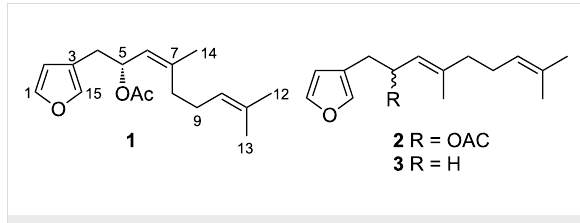
Figure 1: ( − )-(5 R ,6 Z )-Dendrolasin-5-acetate ( 1 ), its 6 E derivative and naturally occuring dentrolasin ( 3 ).